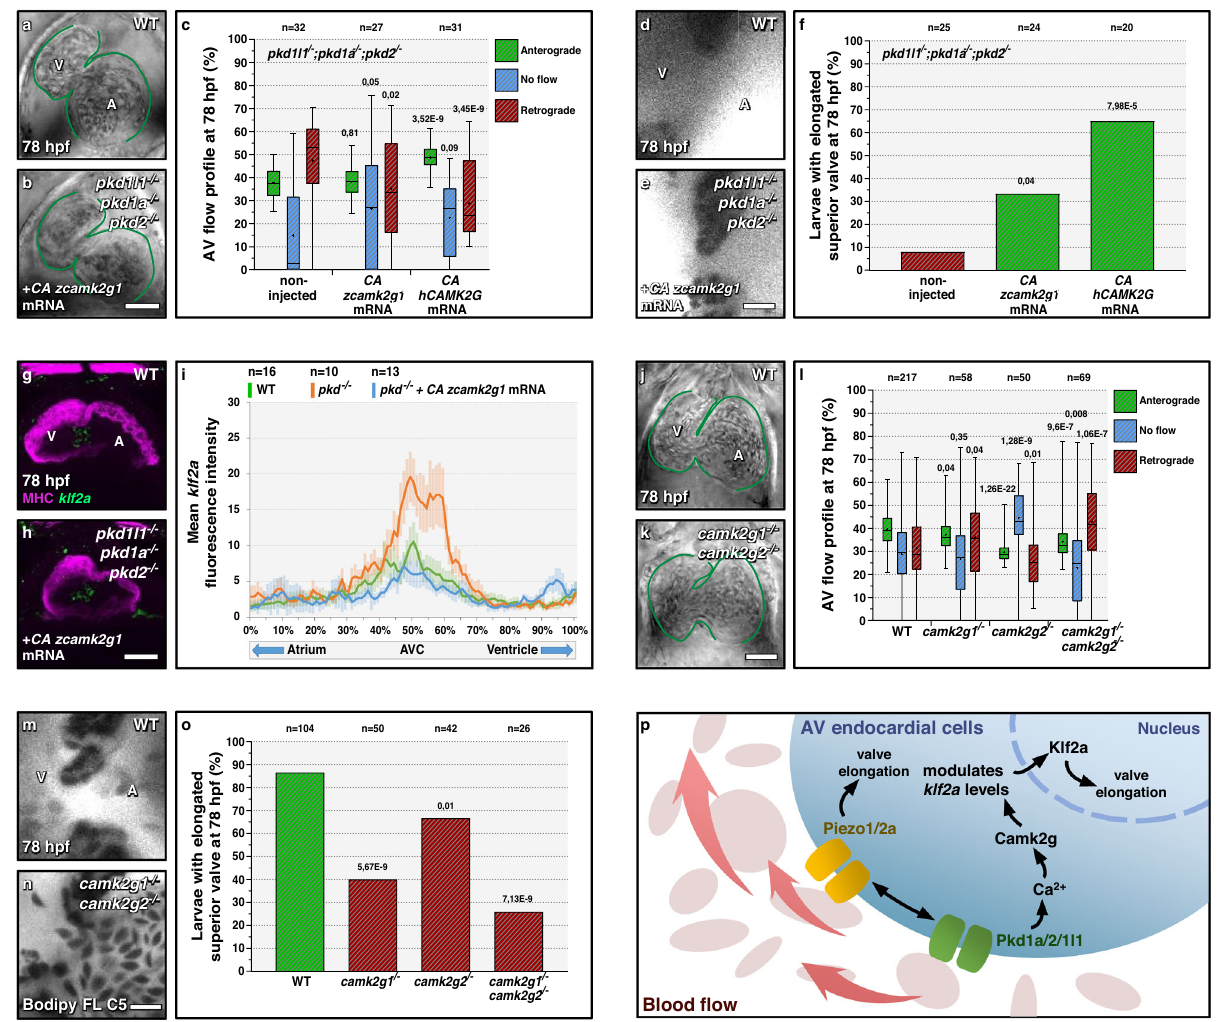
Fig. 6 | Pkd function in atrioventricular valve development is mediated by Camk2g. a , b Bright fi eld images of 78 hpf hearts from non-injected pkd triple mutant ( a ) or injected at the one-cell stage with mRNA encoding a CA zCamk2g1 ( b ). c AV fl ow pro fi le of 78 hpf pkd triple mutant larvae non-injected or injected at the one-cell stage with mRNA encoding CA zCamk2g1 or CA hCAMK2G. d , e Confocal imaging of hearts from 78 hpf non-injected pkd triple mutant ( d ) or injected at the one-cell stage with mRNA encoding CA zCamk2g1 ( e ) and stained with Bodipy. f Superior AV valve elongation of 78 hpf non-injected pkd triple mutants or injected at the one-cell stage with mRNA encoding CA zCamk2g1 or hCAMK2G. g , h Confocal projections of hearts from 78 hpf wild-type ( g ) and pkd triplemutant injected atthe one-cell stage with mRNA encoding CA zCamk2g1( h ), stainedforMHCand klf2a expression. i klf2a fl uorescenceintensityalongtheheart tubein78hpfwildtypesand pkd triplemutantsnon-injectedorinjectedattheone-